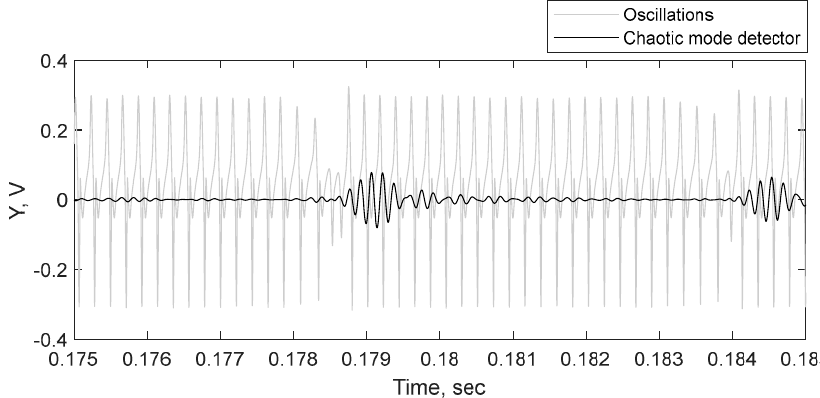
Figure 22. Closer view of the detection filter output. The chaotic mode detector is sensitive to the presence of chaos in the circuit oscillations (grey line) and it responds with the increase in amplitude (black line).